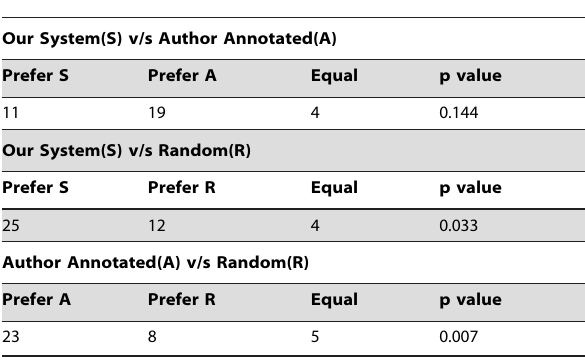
Table 5. Evaluation of figure ranking by being integrated into novel user interface(UI-1 in Figure 7).